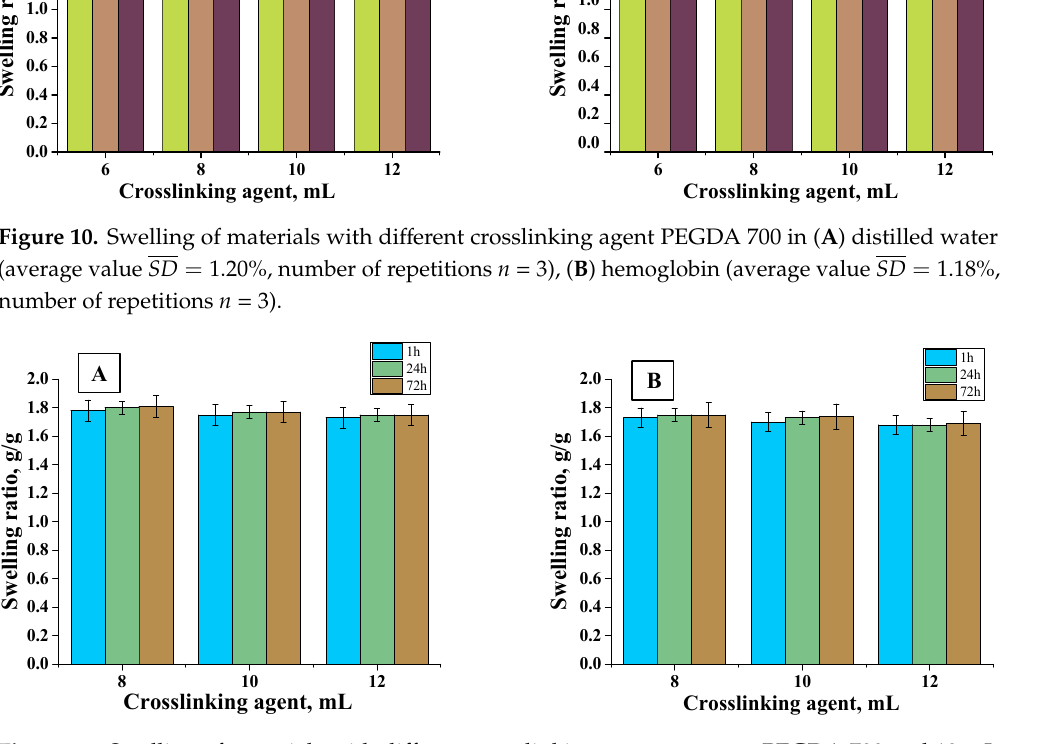
Figure 11. Swelling of materials with di ff erent crosslinking agent contents, PEGDA 700 and 10 mL of Aloe vera juice in ( A ) distilled water (average value SD = 1.11%, number of repetitions n = 3), ( B ) hemoglobin (average value SD = 1.13%, number of repetitions n = 3).